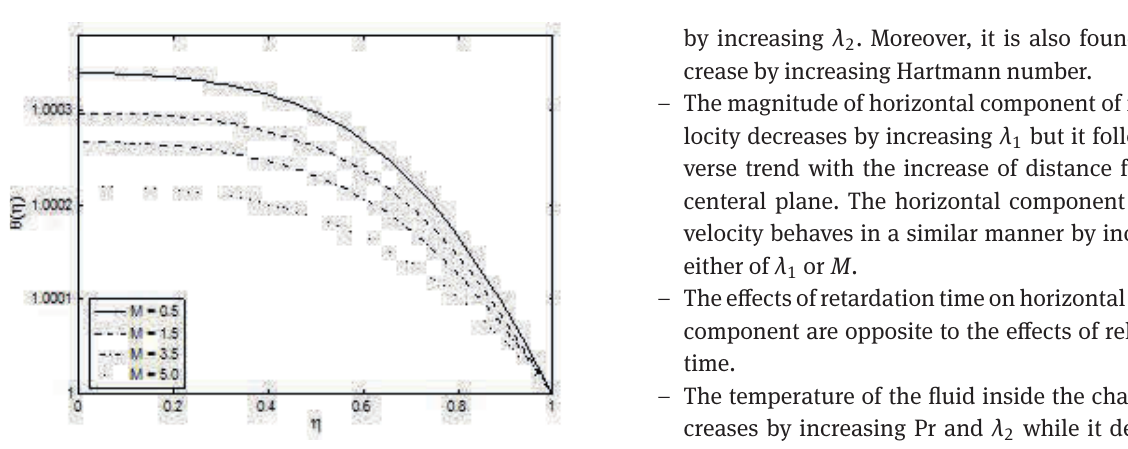
Fig. 9: Variation of non-dimensional temperature with η for different values of M for λ 1 = 0.5, Pr = 15 and λ 2 = 0.05.